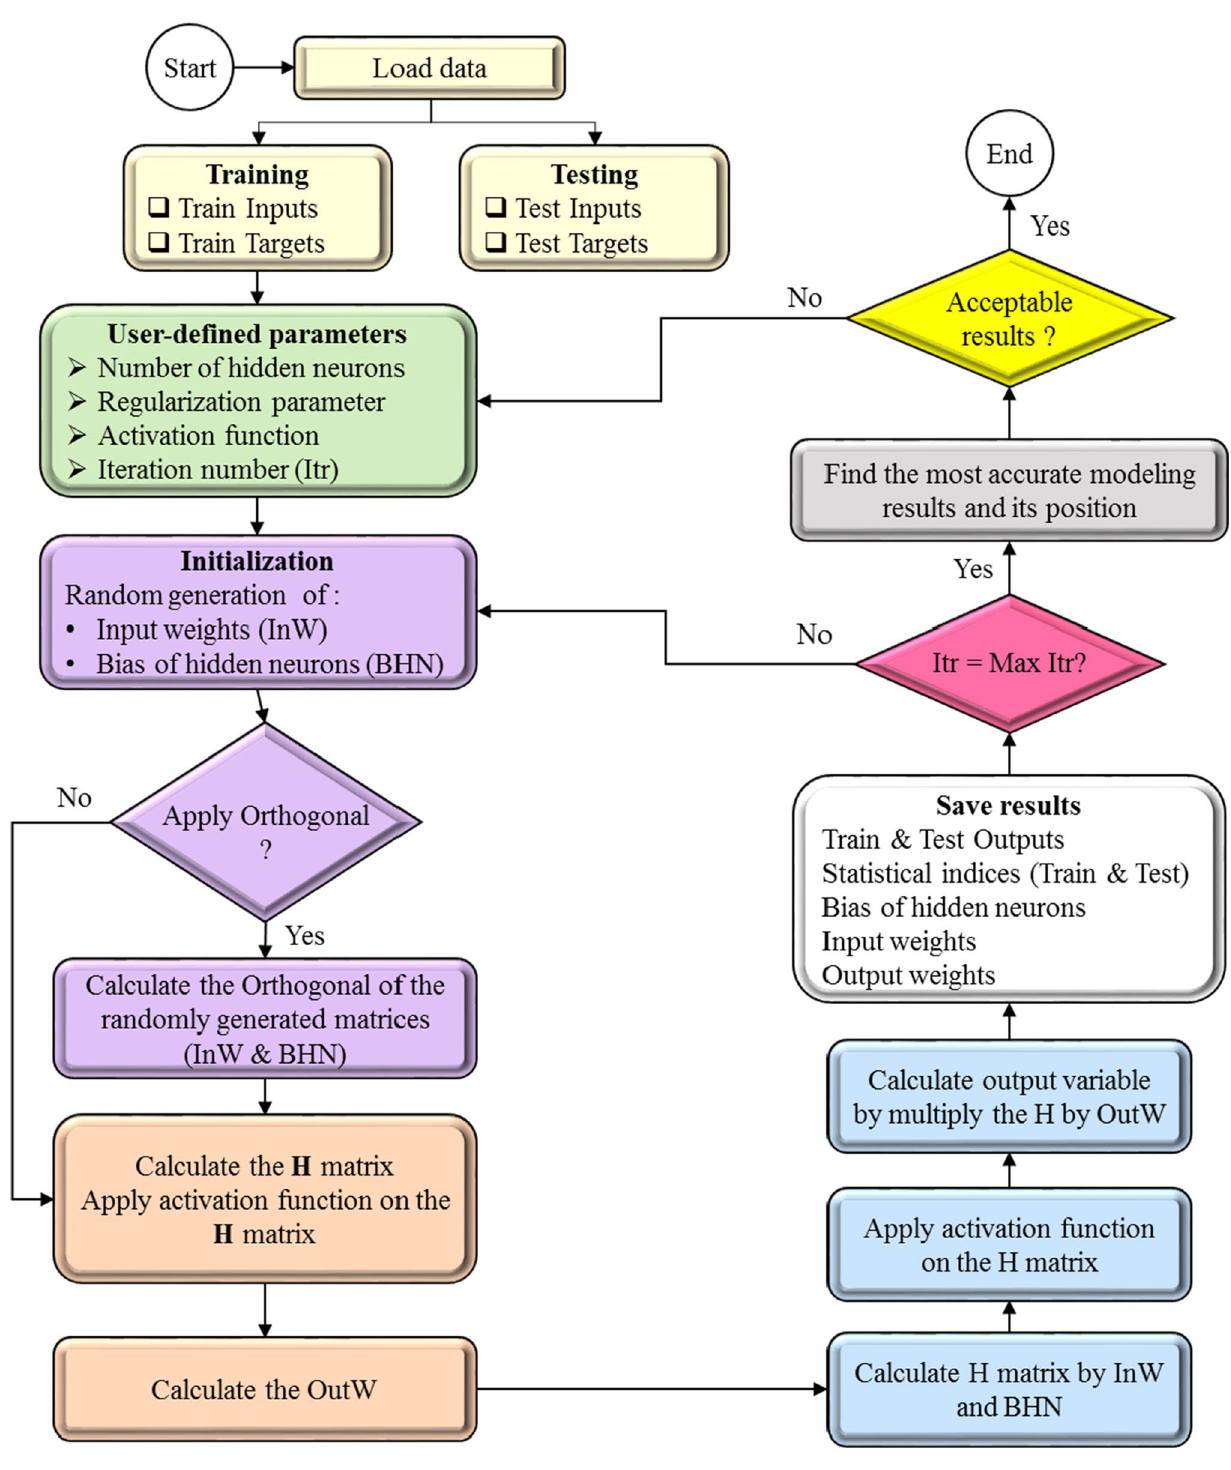
Fig. 2 Flowchart of